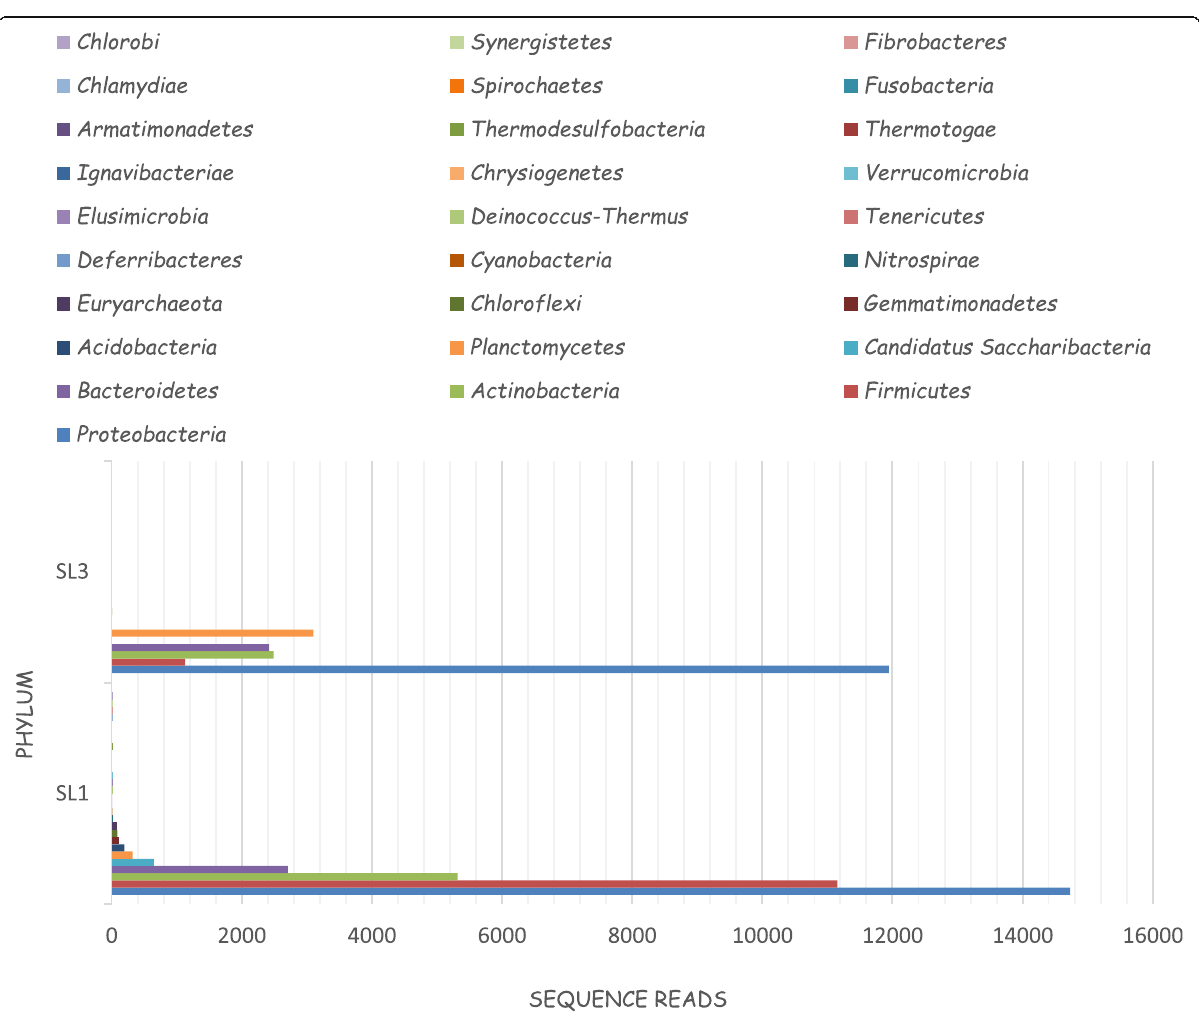
Fig. 1 Phylum classification of SL1 and SL3 metagenomes. Unclassified reads were not used for the analysis. All the phyla detected in SL1 and SL3 metagenomes were